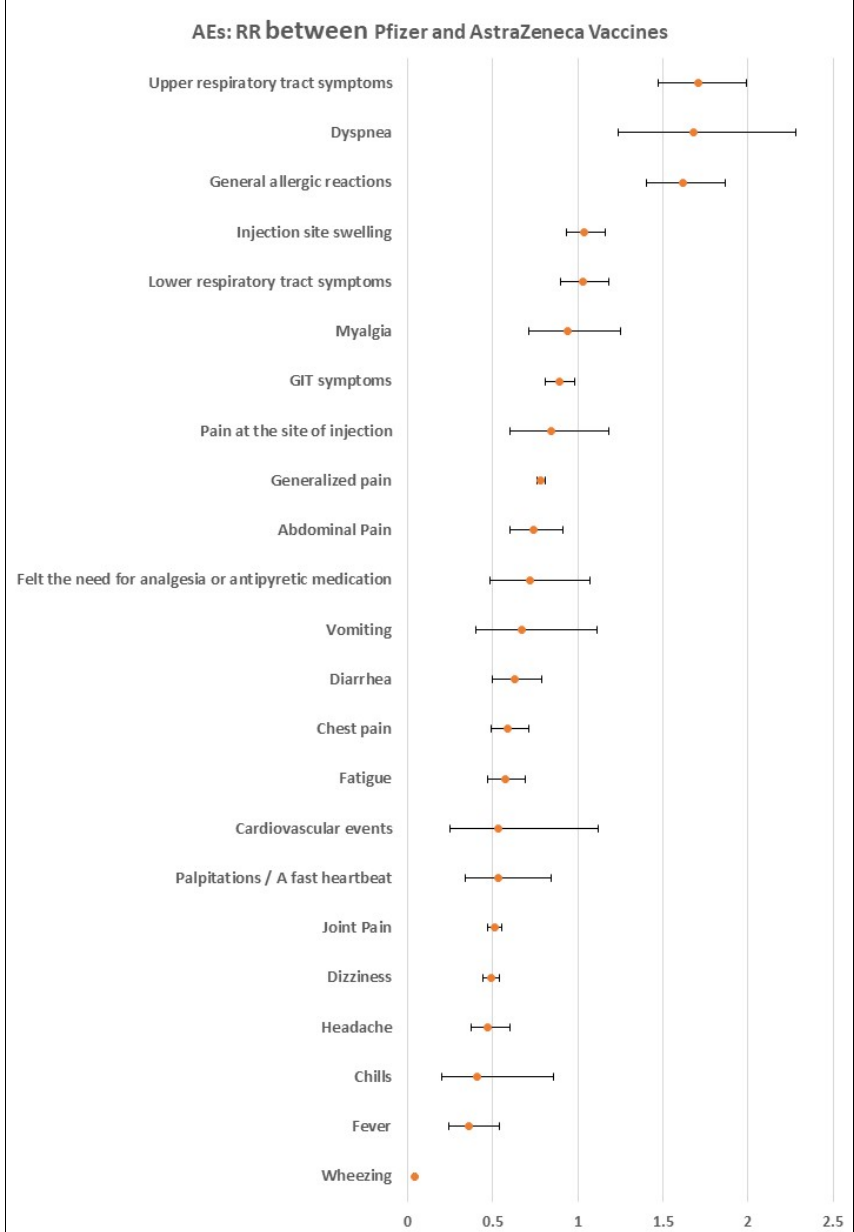
Figure 4. Forest plot of AEs in Pfizer group compared with AstraZeneca group. Most common AEs: Table 2 showed that the most common AEs in participants who received the Pfizer ‐ BioNTech vaccine were pain at the site of injection 59.3% (95% CI:44.3–